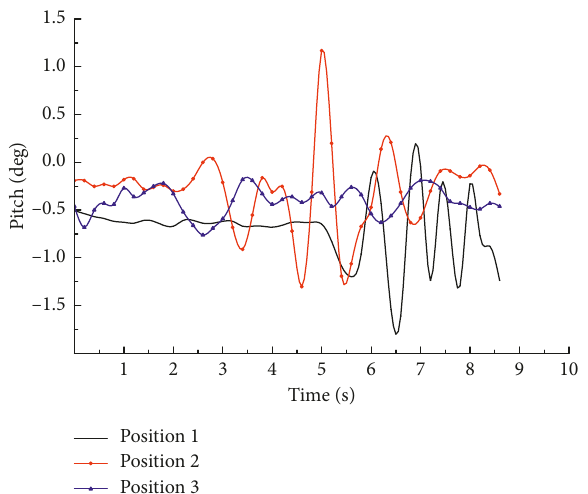
Figure 15: Time history curve of the pitching motion of the ship under different navigation positions.